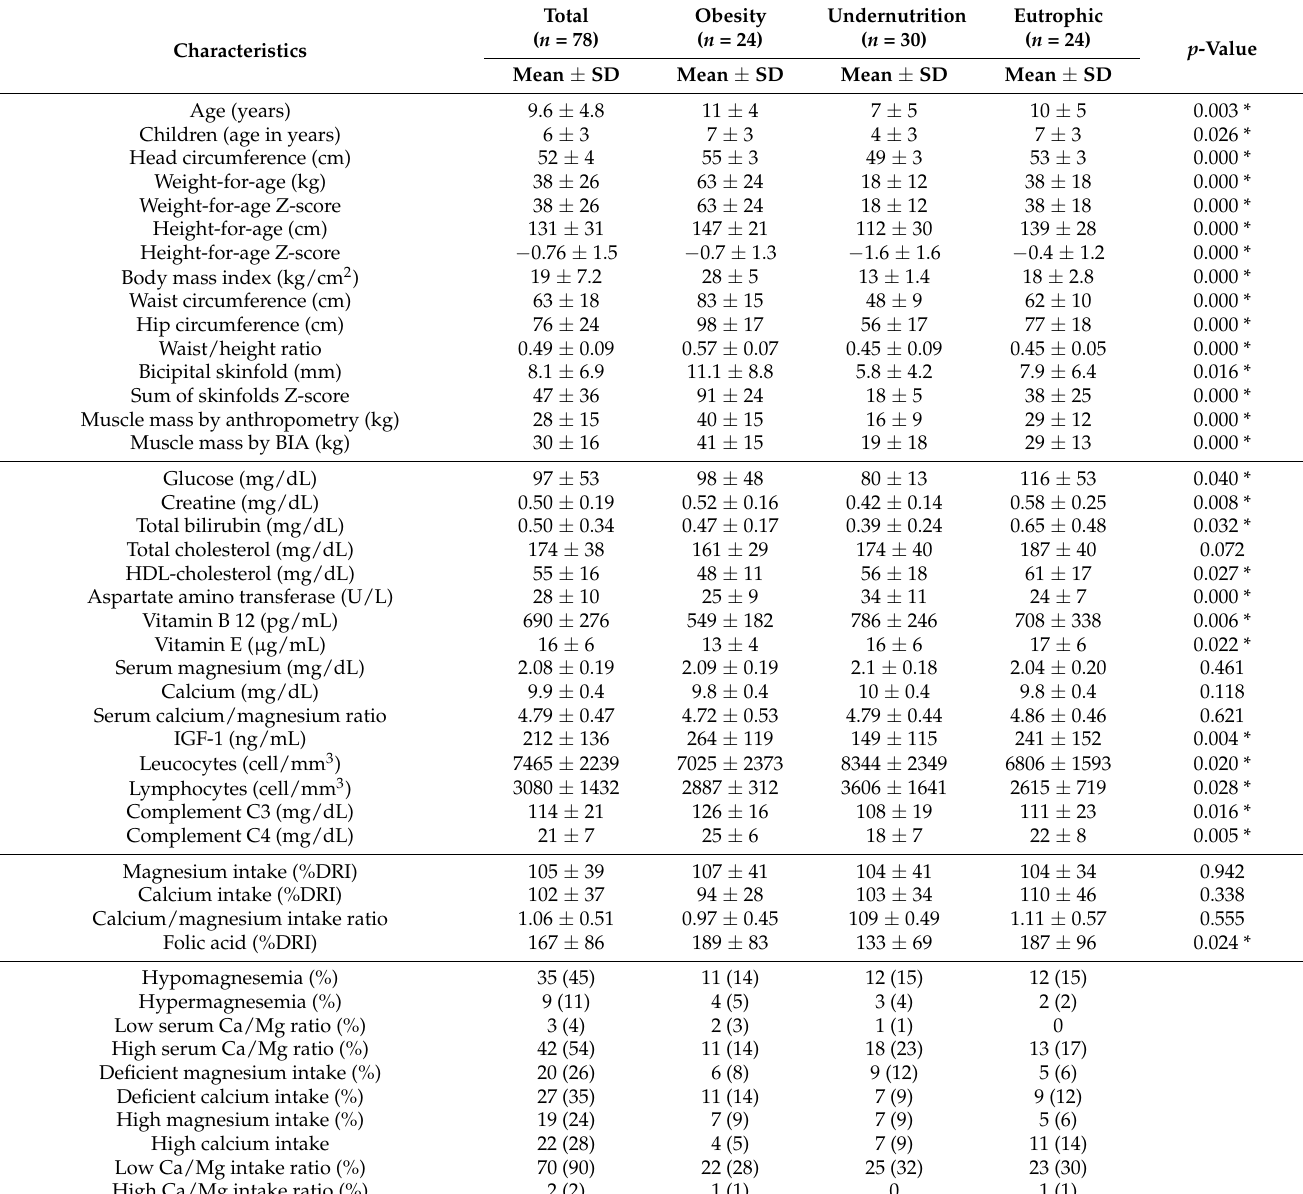
Table 1. Baseline characteristics of children with chronic disease by BMI groups ( n =